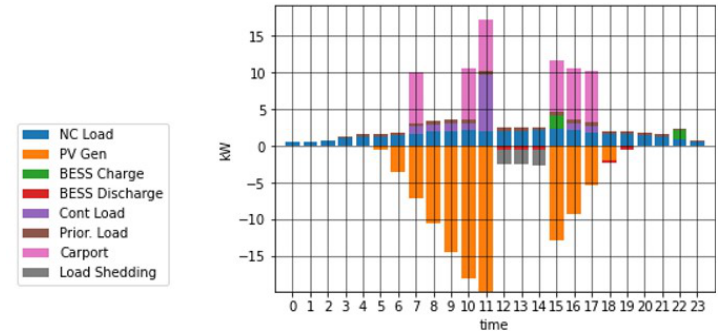
Figure 8. Dispatch proposed by the microgrids for scheduled islanding.